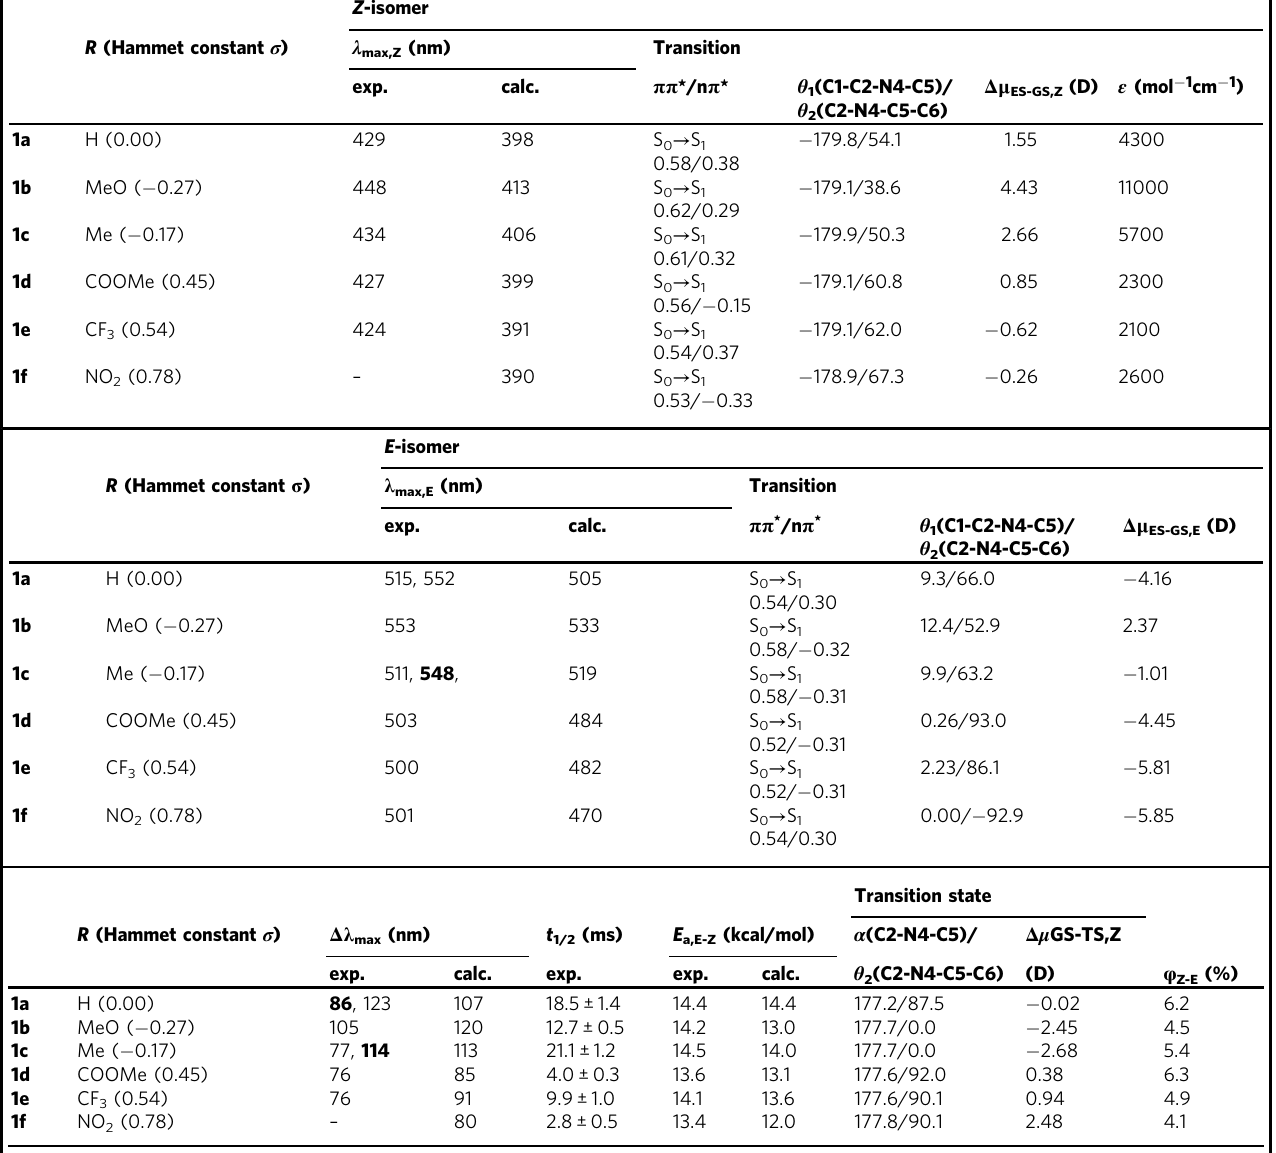
Table 2 Computational studies on substituent effects on ITI